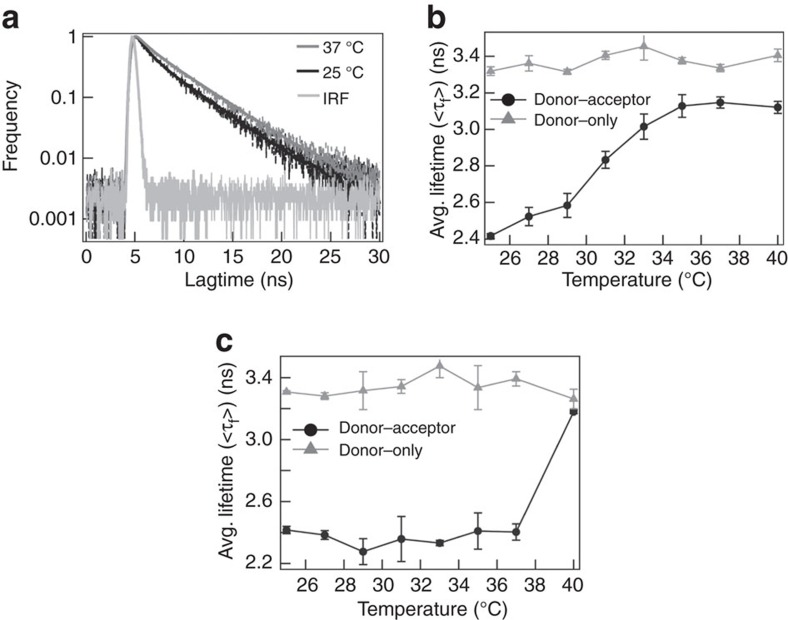
Expansion of DENV2 and DENV1 captured by TR-FRET.(a) Representative fluorescence lifetime decay curve of AF488-TFP for dual labelled DENV2 at 25 (black) and 37 °C (grey), including the impulse response function (IRF) of the instrument. The lifetime traces are fitted with a two-component model. The average fluorescence lifetimes (<τf>) of AF488-TFP for donor-only labeled, <τf,SL> (grey triangles), and dual labelled, <τf,SL> (black circles), for DENV2 (NGC) (b) and DENV1 (PVP 159) (c). Error bars represent s.d.'s of six different experimental replicates in both DENV2 and DENV1 viruses. The temperature in these two cases was increased from 25 to 40 °C. The midpoint temperature of the transition was at ∼33 °C and greater than 37 °C for DENV2 and DENV1, respectively.